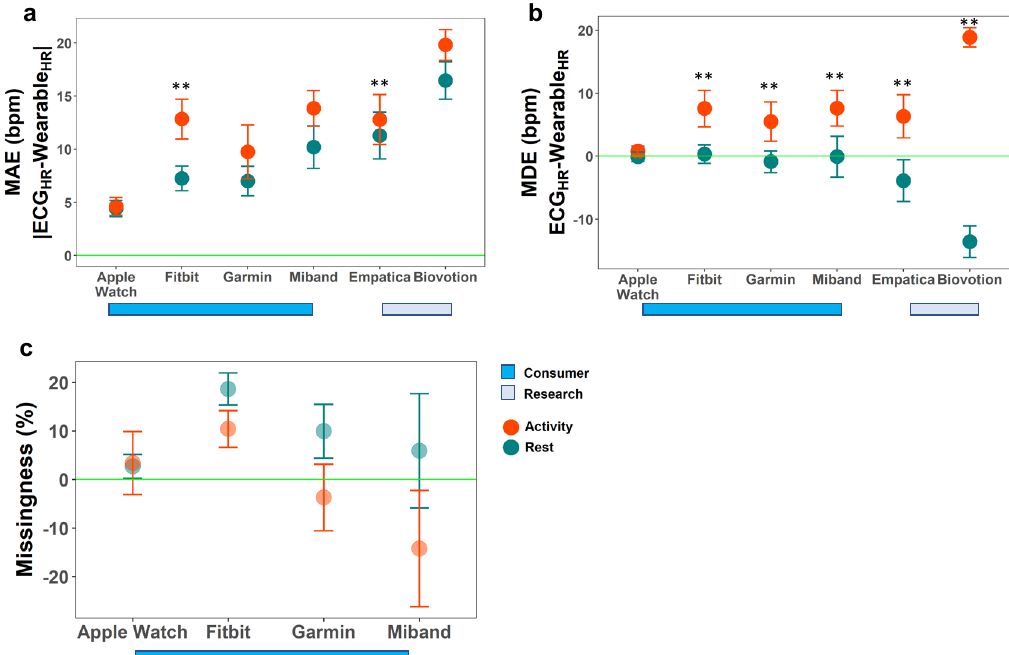
Fig. 3 Error in heart rate across all devices and analysis of missing values across consumer devices. a Mean absolute error in heart rate (bpm) across devices during rest (teal) and activity (orange). This shows the true difference in HR from the ECG but does not show the sign of the difference. The green horizontal line represents no error (no difference from the true measurement of HR from ECG). Error bars show the 95% con fi dence interval. ** indicates signi fi cant difference in error between baseline and activity with a Bonferroni multiple hypothesis corrected p value of 0.0042. b Mean relative error in heart rate (bpm) across devices during rest (teal) and during activity (orange) shows the relative differences from the ECG. The green horizontal line represents no error (no difference from the true measurement of HR from ECG). Error bars show the 95% con fi dence interval. ** indicates signi fi cant difference in error between baseline and activity with a Bonferroni multiple hypothesis corrected p value of 0.0042. c Analysis of missing values across skin tones for rest and activity for consumer wearables. Research-grade wearables (Empatica, Biovotion) down-sample and/or interpolate to have exactly 1 Hz sampling rate and thus we could not calculate missingness values for those devices. Missingness is calculated from the expected sampling rate (reported sampling rate for Apple Watch and Garmin and study average sampling rate for Garmin and Miband, which do not report sampling rate). Missingness that is positive indicates percentage of values with missingness. Missingness that is negative indicates a greater than expected sampling rate (more values than